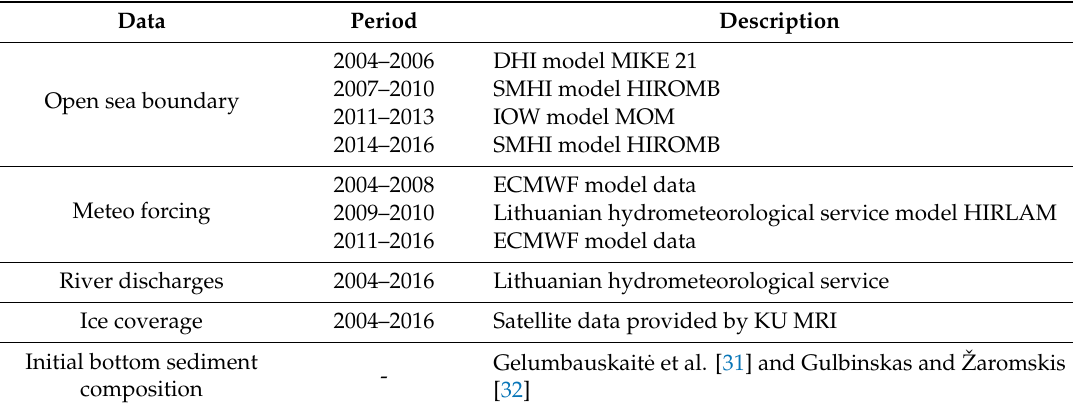
Table 2. The summary of the model set up